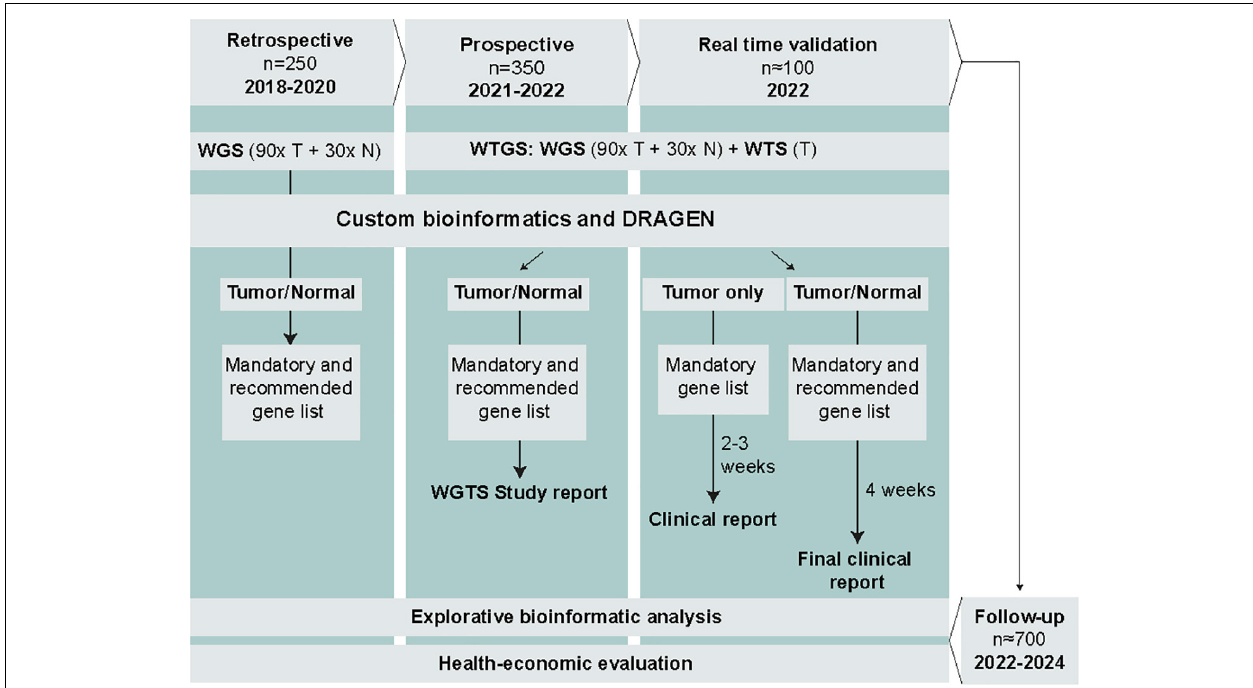
FIGURE 1 | Overview of the study phases, planned data generation, analysis, and reporting. Results from SoC diagnostics will be collected in parallel for all patients. T, tumor; N, normal; WGS, whole-genome sequencing; WTS, whole-transcriptome